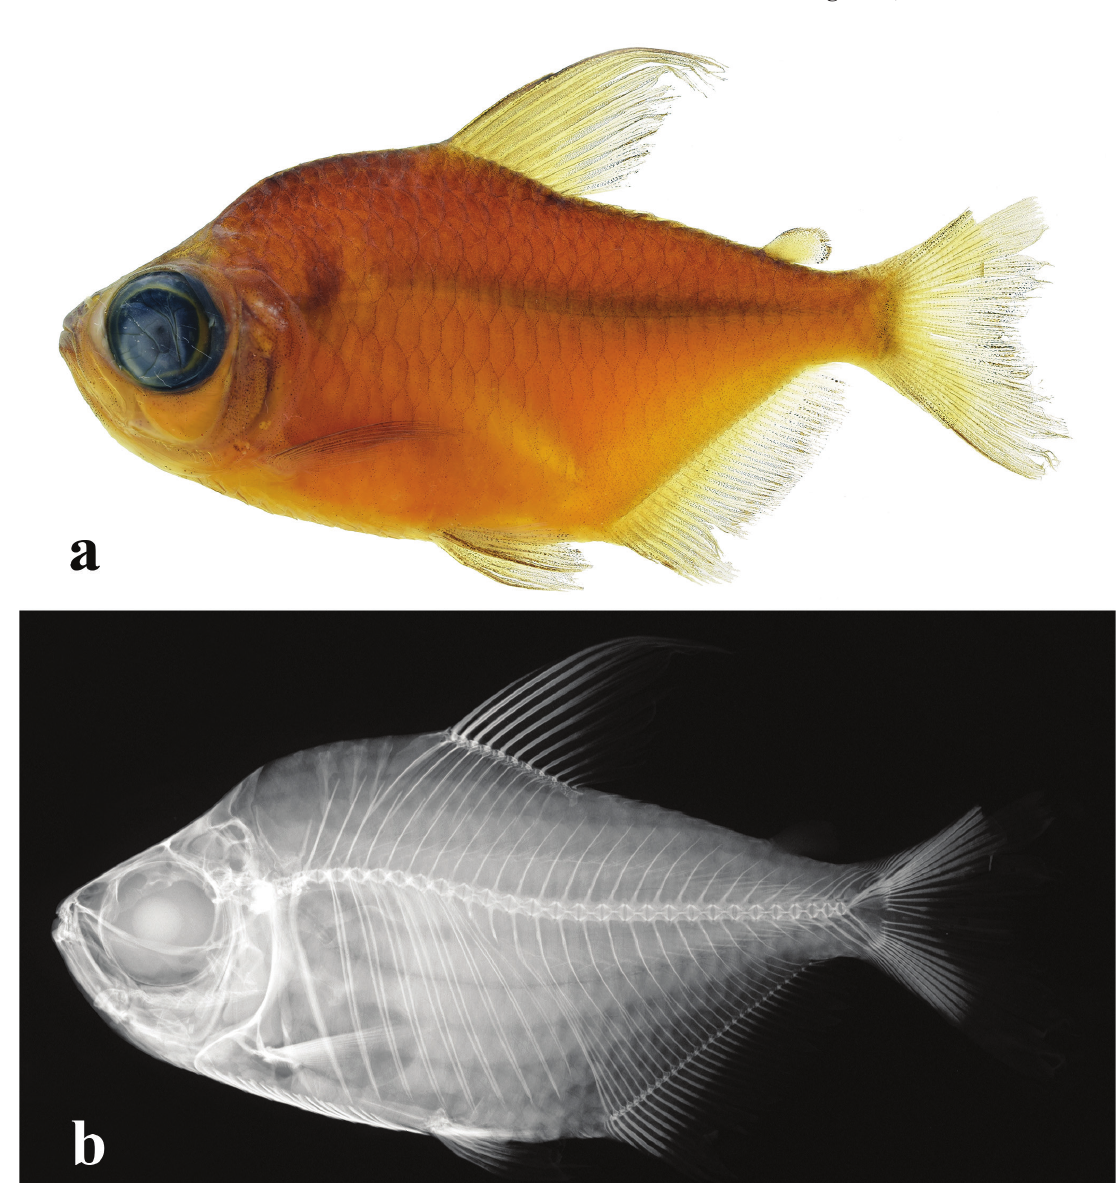
Fig. 1. a. Tetragonopterus manaos , holotype, MZUSP 117250, 64.1 mm SL, Brazil, Manaus, Anavilhanas National Park, rio Negro, Amazon basin; b. radiograph of the